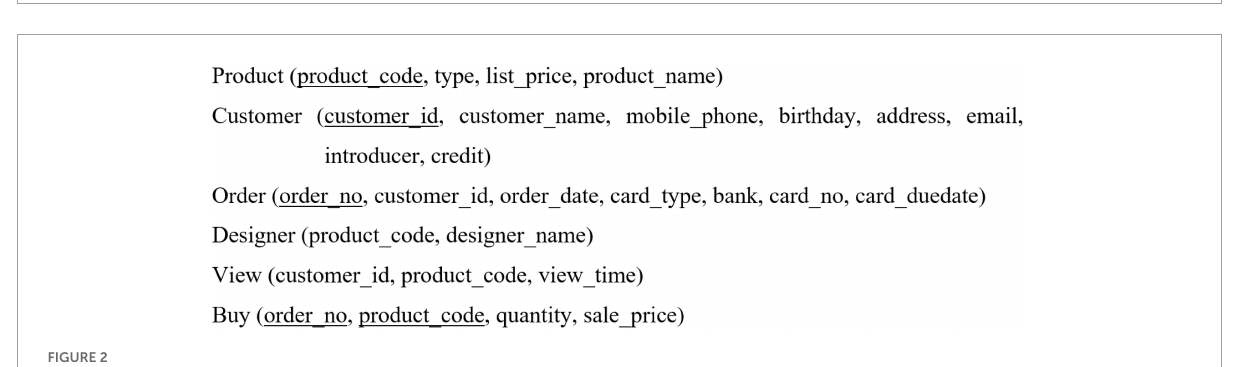
FIGURE2 Relational schema of the data request in Figure 1